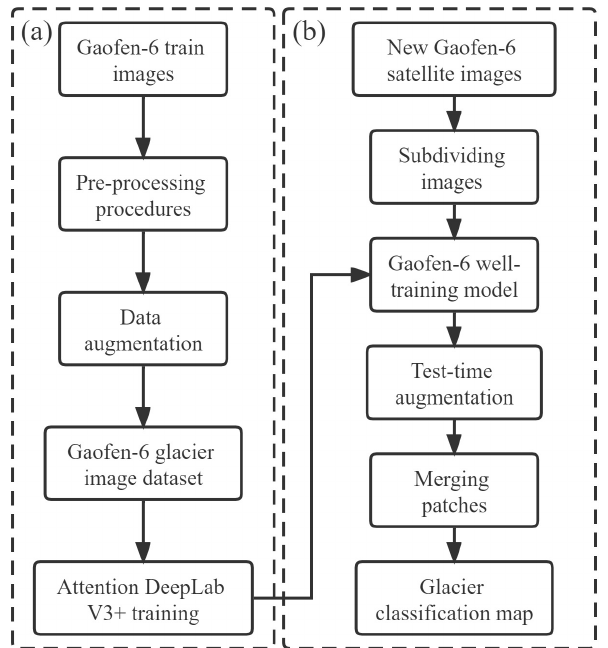
Figure 1. Overall flow of glacier extraction based on deep learning. (a) The model training. (b) The prediction process. (Sect. 2.1.4) and a bilinear interpolation upsampling with